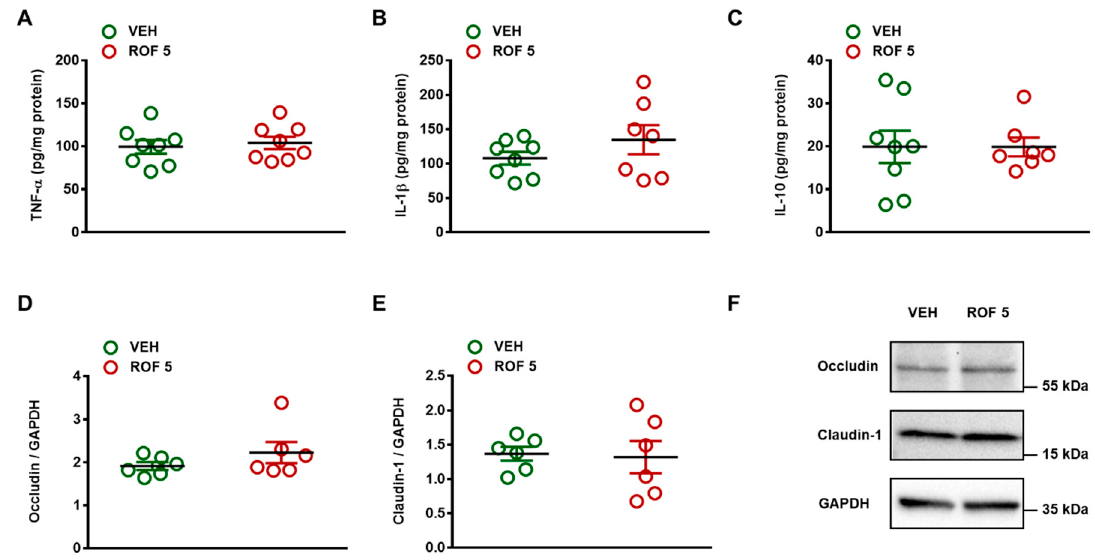
Figure 3. The effect of four-week vehicle (VEH, 1% methylcellulose) and rofecoxib (ROF, 5 mg/kg) treatment on the tissue protein levels of TNF- α ( A , n = 8/group), IL-1 β ( B , n = 7–8/group), IL-10 ( C , n = 7–8/group), occludin ( D , n = 6/group), and claudin-1 ( E , n = 6/group) in the distal jejunum of rats. Circles represent the data of each rat, bars indicate the mean ± SEM. For statistical analysis, Student’s t test was used. Panel F : Representative Western blots for occludin and claudin-1 proteins in the distal jejunum of vehicle- and rofecoxib-treated rats.